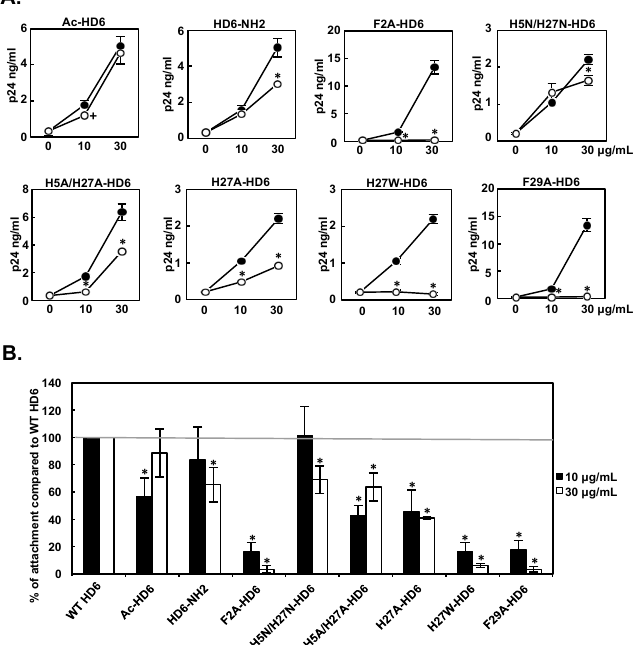
Table 2. Summary of the effect of HD5 mutants on HIV attachment-enhancing activity and infection- enhancing activity. Data are means ± SD of seven independent experiments, and represent the average relative percent of HIV attachment or infectivity by HD5 mutants compared to WT HD5 at the same concentration. Figure 5. Effect of HD6 mutants on HIV attachment-enhancing activity. WT HD6 or HD6 mutants were pre-incubated with serum-free HIV-1 JR-FL before incubation with HeLa-CD4-CCR5 cells at 4 ◦ C for 1 h. After washing off unbound viruses, cell-associated p24 was measured. ( A ) Results of a representative independent experiment for WT HD6 (filled circles) and each HD6 mutant (open circles) are shown. The baseline HIV p24 value (HIV without defensin) was 204–305. Data are means ± SD of triplicate samples and represent six independent experiments. * p < 0.05, WT HD6 versus HD6 mutants at the same concentration; 2-tailed Student’s t -test. After Bonferroni correction, the difference between WT HD6 and Ac-HD6 at 10 μ g/mL was not significant (+ p > 0.05). ( B ) Data represent the average relative percent of enhanced HIV attachment by mutants compared to WT HD6 from six independent experiments. * p < 0.05, WT HD6 versus HD6 mutants at the same concentration by one- way ANOVA with Bonferroni post-test. Table 3. Summary of the effect of HD6 mutants on HIV attachment-enhancing activity and infection- enhancing activity. Data are means ± SD of six independent experiments, and represent the average relative percent of HIV attachment or infectivity by HD6 mutants compared to WT HD6 at the same concentration. WT HD6 100 ± 0 100 ± 0